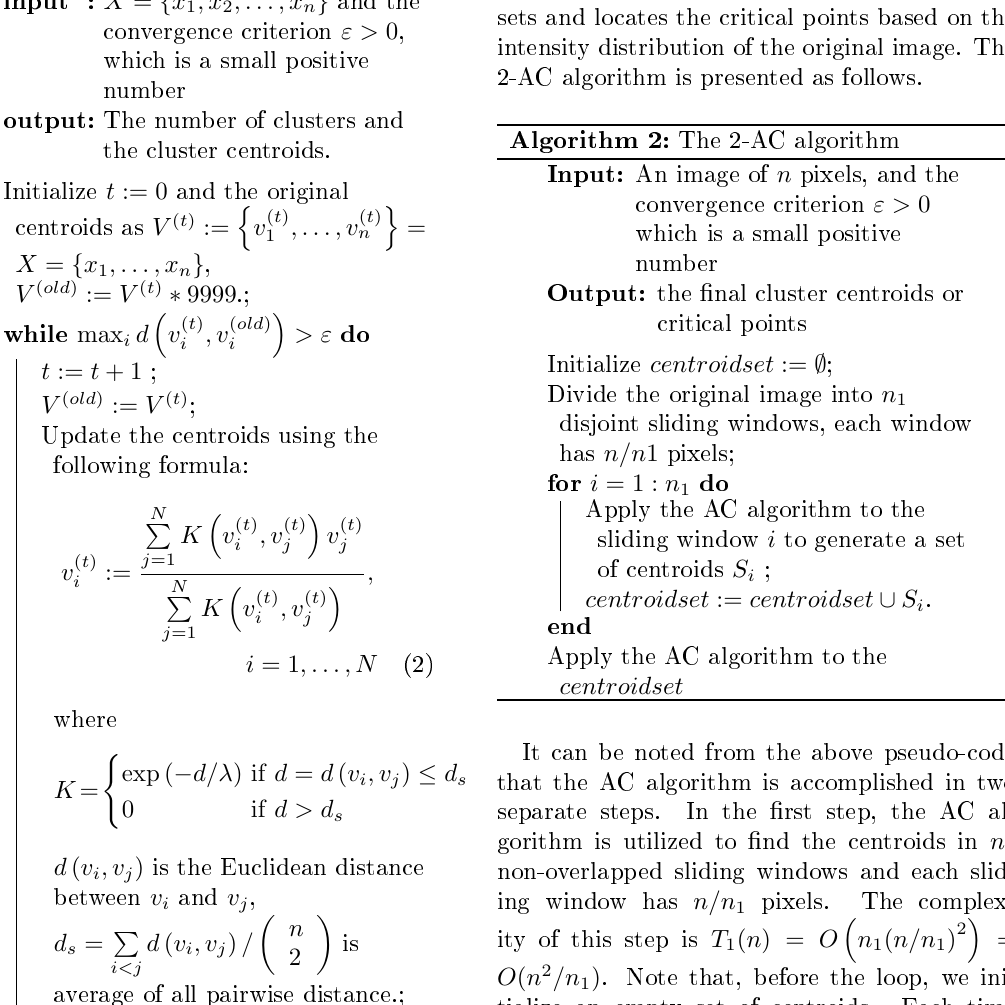
Algorithm 1: The AC algorithm